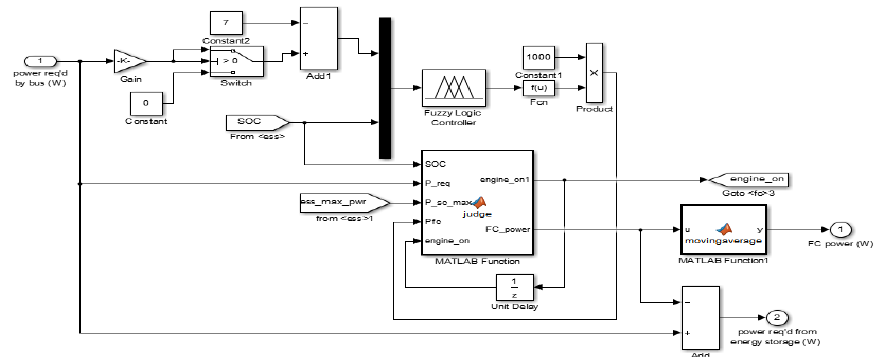
Figure 6. Compound energy management control.